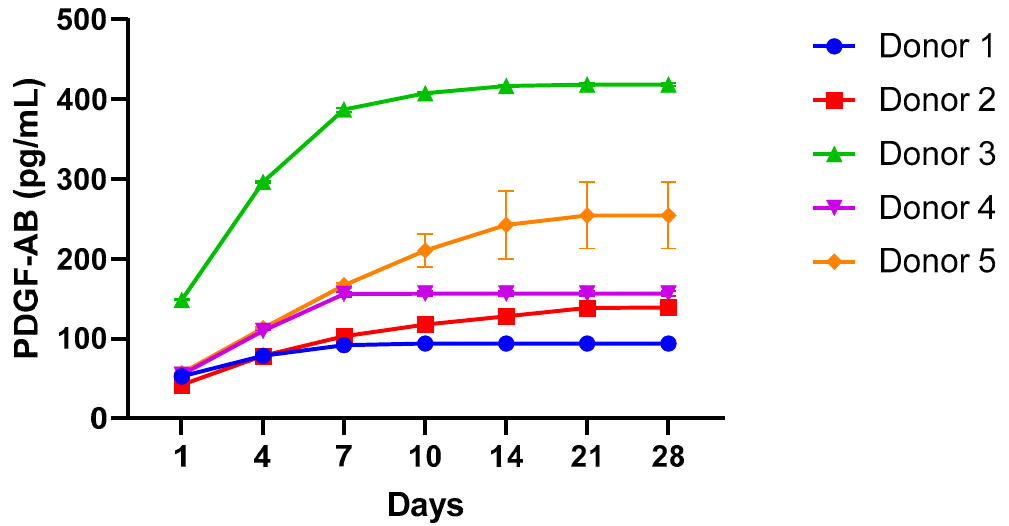
Figure 7. Cumulative kinetics for PDGF-AB growth factor release from five donors samples. Data presented as mean ± SD of five biological replicates (n = 5) with 2 technical replicates (n = 2).